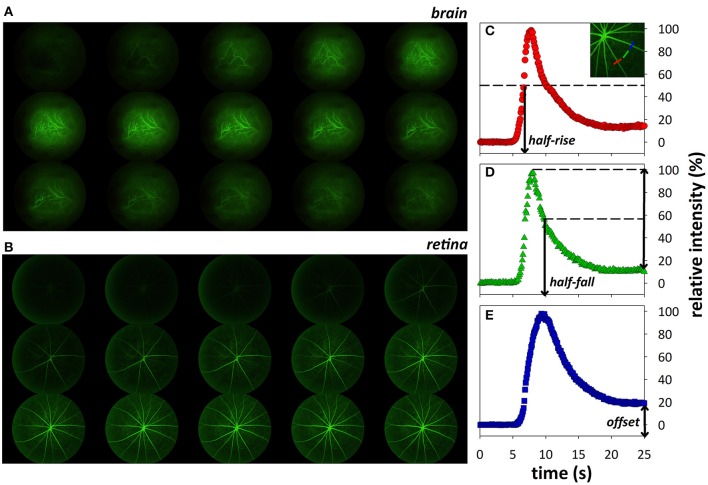
Montage (every 20th frame of video recording) showing fluorescein transit through cortical (A) and retinal (B) vasculature 5.2–15.8 s after onset of fluorescein infusion. Representative intensity profiles showing how fluorescence indices, half-rise (C), half-fall (D), and offset (E), were derived.